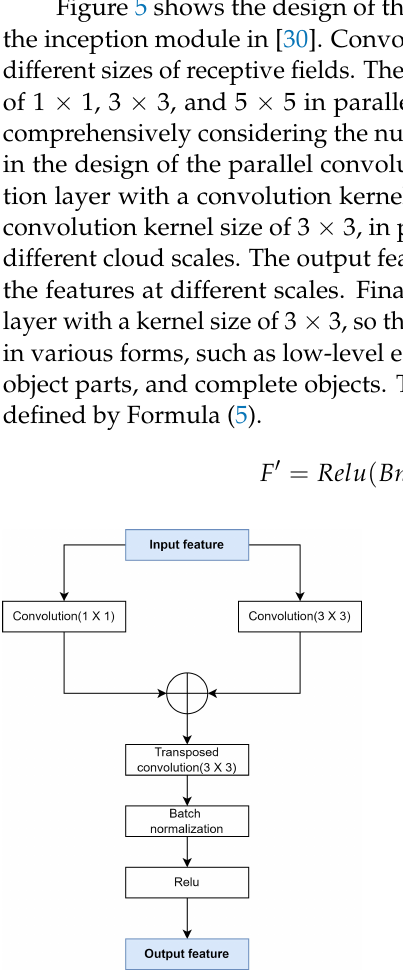
Figure 5. Parallel convolution block.